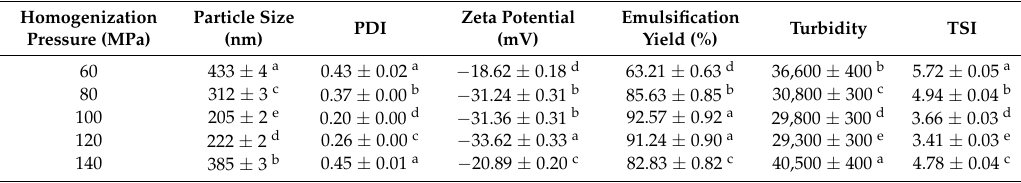
Table 3. Effect of homogenization pressure on emulsion stability of nanoemulsions.